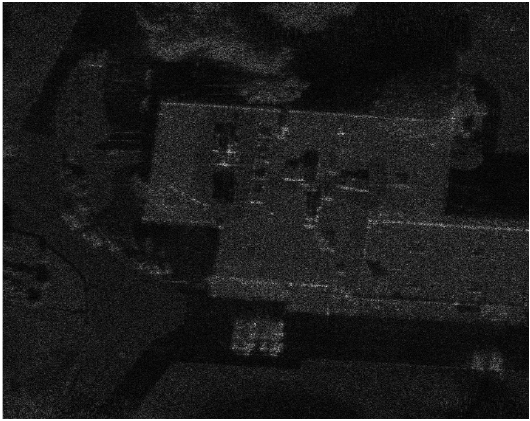
Figure 14. Accurate imaging results of